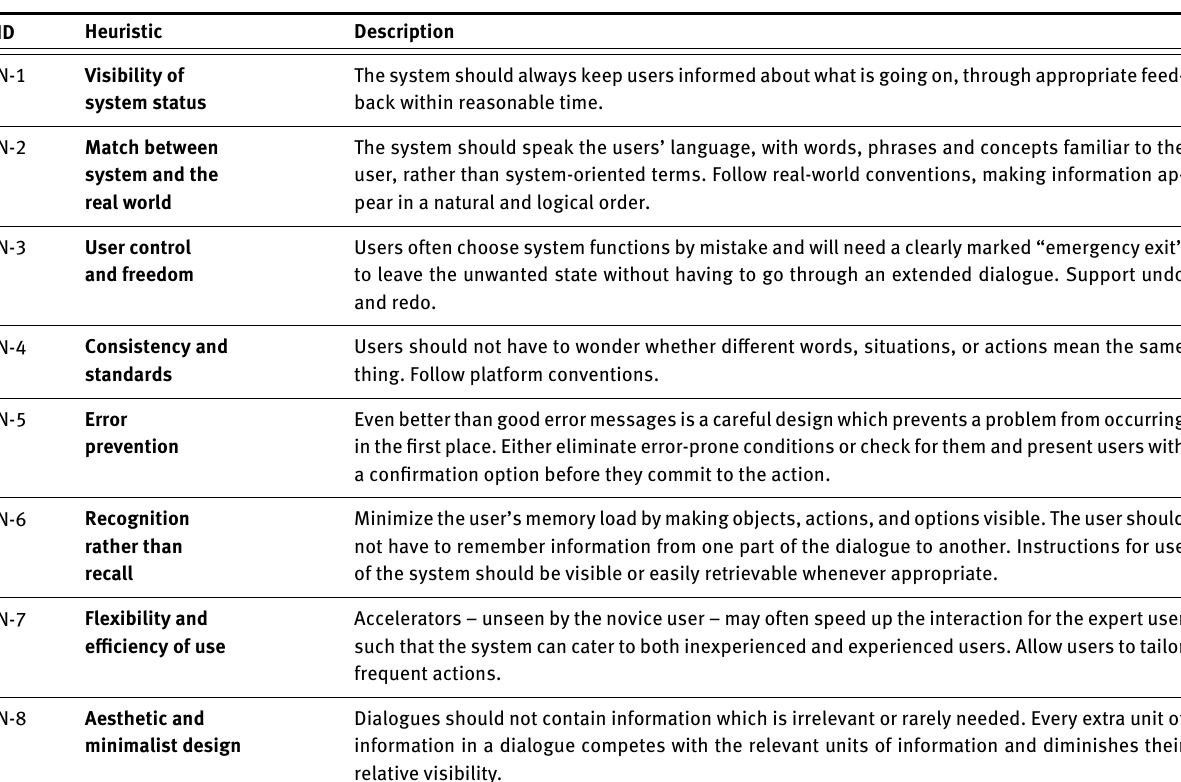
Table 9. Relevant Nielsen Usability Heuristics [51, 53]